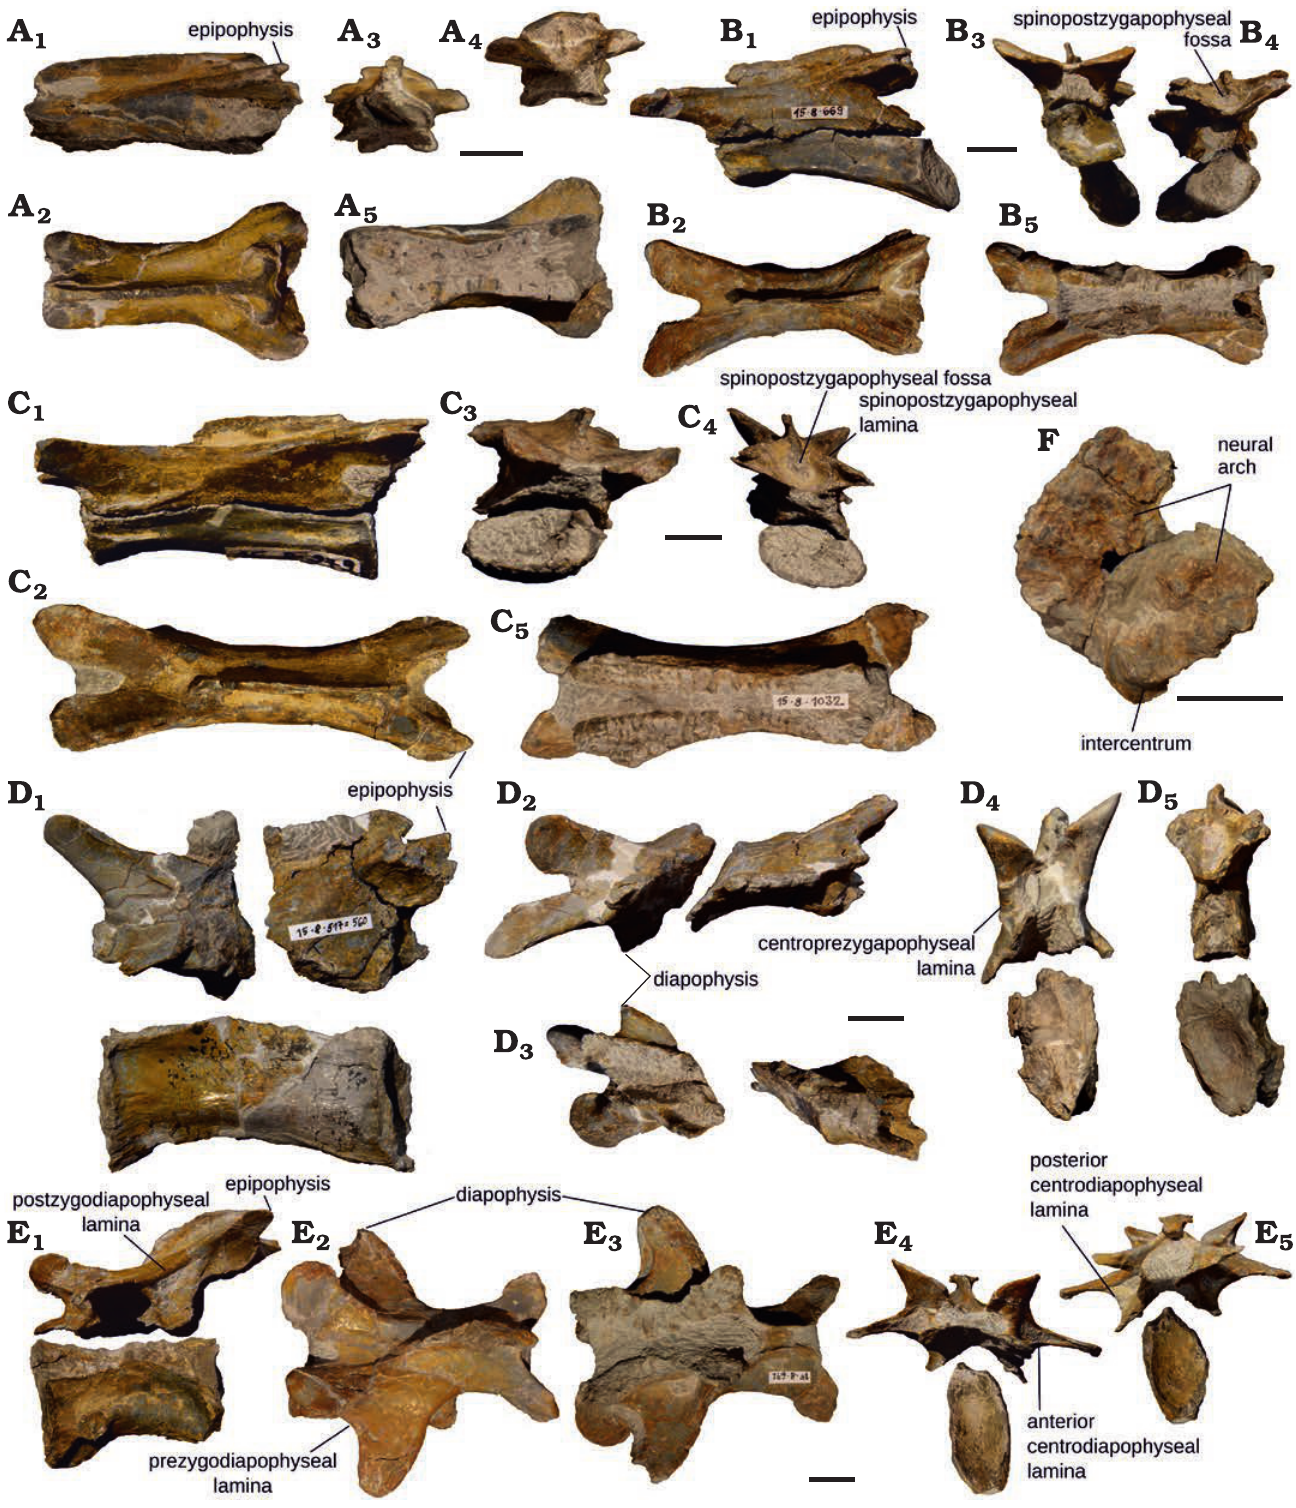
Fig. 2. Cervical vertebrae of juvenile Plateosaurus cf. trossingensis Fraas, 1913 skeleton MSF 15.8B. from the Norian of Frick, Switzerland. A . Cervical vertebra 2 (axis), MSF 15.8.2001, in left lateral (A 1 ), dorsal (A 2 ), anterior (A 3 ), posterior (A 4 ), and ventral (A 5 ) views. B . Cervical vertebra 3, MSF 15.8.669 (neural arch) and MSF 15.8.936 (centrum), in left lateral (B 1 ), dorsal (B 2 ), anterior (B 3 ), posterior (B 4 ), and ventral (B 5 ) views, C . Cervical vertebra 4, MSF 15.8.1032 (neural arch) and MSF 15.8.979 (centrum), in left lateral (C 1 ), dorsal (C 2 ), anterior (C 3 ), posterior (C 4 ), and ventral (C 5 ) views. D . Cervical vertebra 6, MSF 15.8.2002 (neural arch) and MSF 15.8.592 (centrum), in left lateral (D 1 ), dorsal (D 2 ), ventral (D 3 ), anterior (D 4 ), and posterior (D 5 ) views. E . Cervical vertebra 9, MSF 15.8.671 (neural arch) and MSF 15.8.905 (centrum), in left lateral (E 1 ), dorsal (E 2 ), ventral (E 3 ), anterior (E 4 ), and posterior (E 5 ) views. F . Cervical vertebra 1 (atlas), MSF 15.8.2000, in ?anterior view. Centra are omitted in ventral view to show neural arch. Scale bars 10